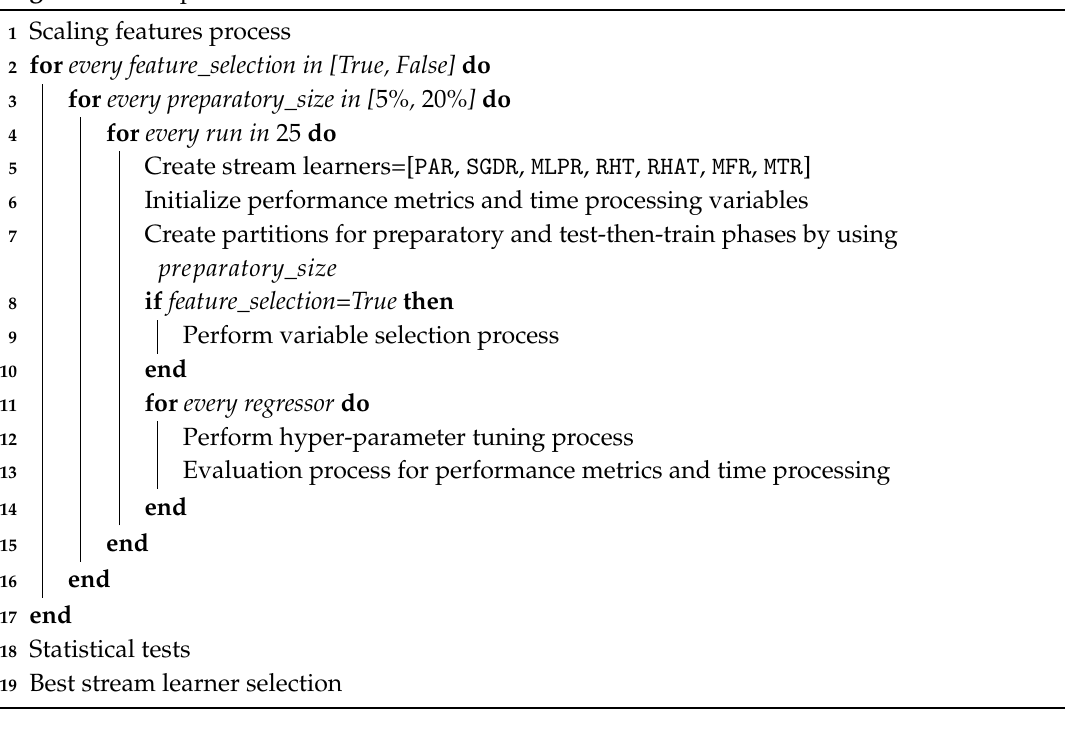
Algorithm 1: Experimental benchmark structure.